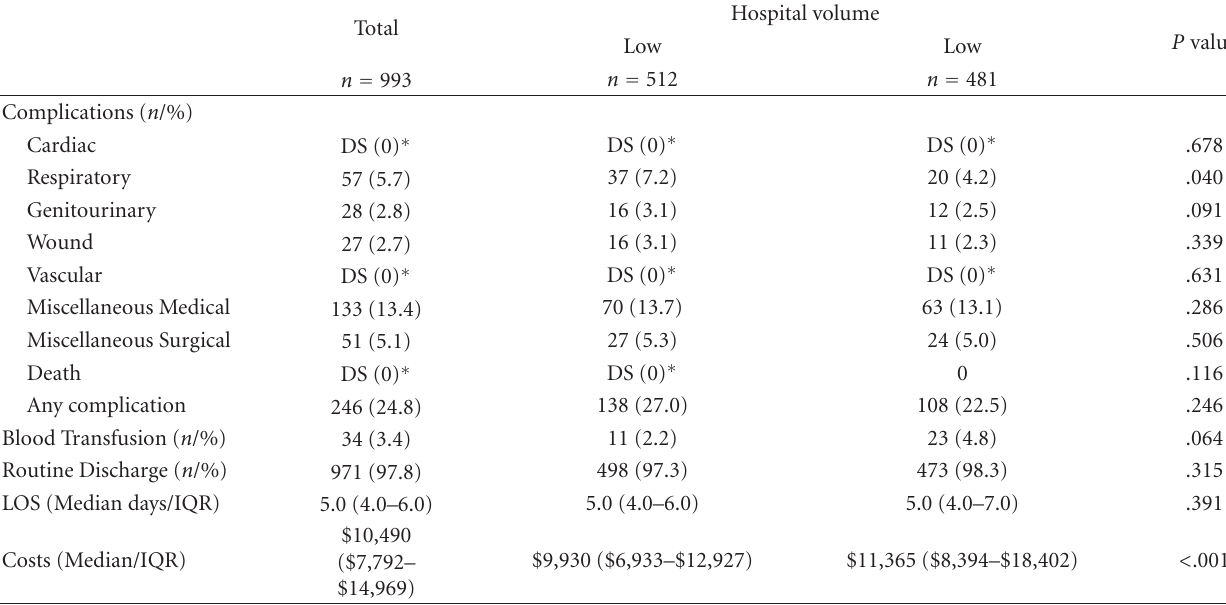
Table 2: RPLND outcomes and costs by dichotomous hospital